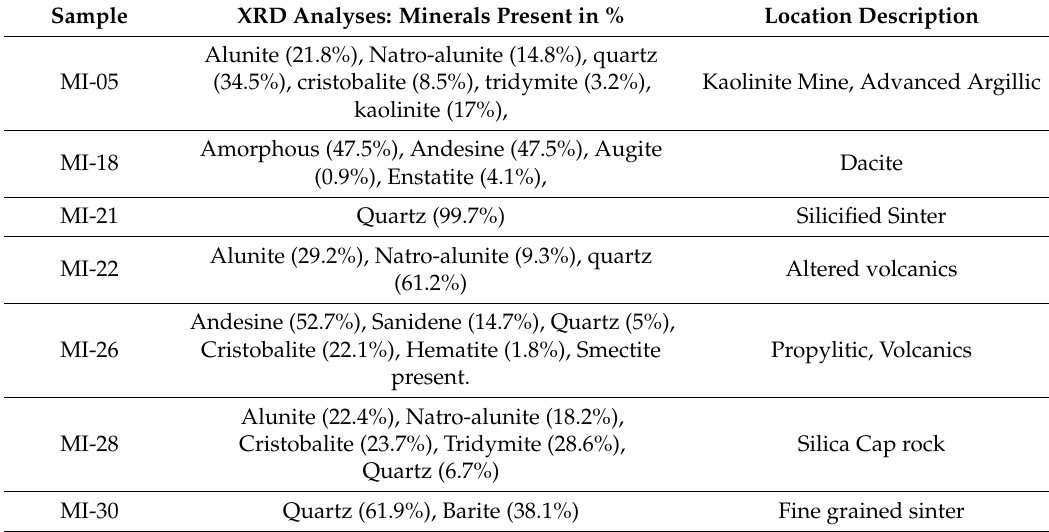
Figure 3. ( a ) Field Spectra. ( b ) Field spectra resampled to the DAIS SWIR bandwidths. Table 1. Mineralogy and description of the field locations of